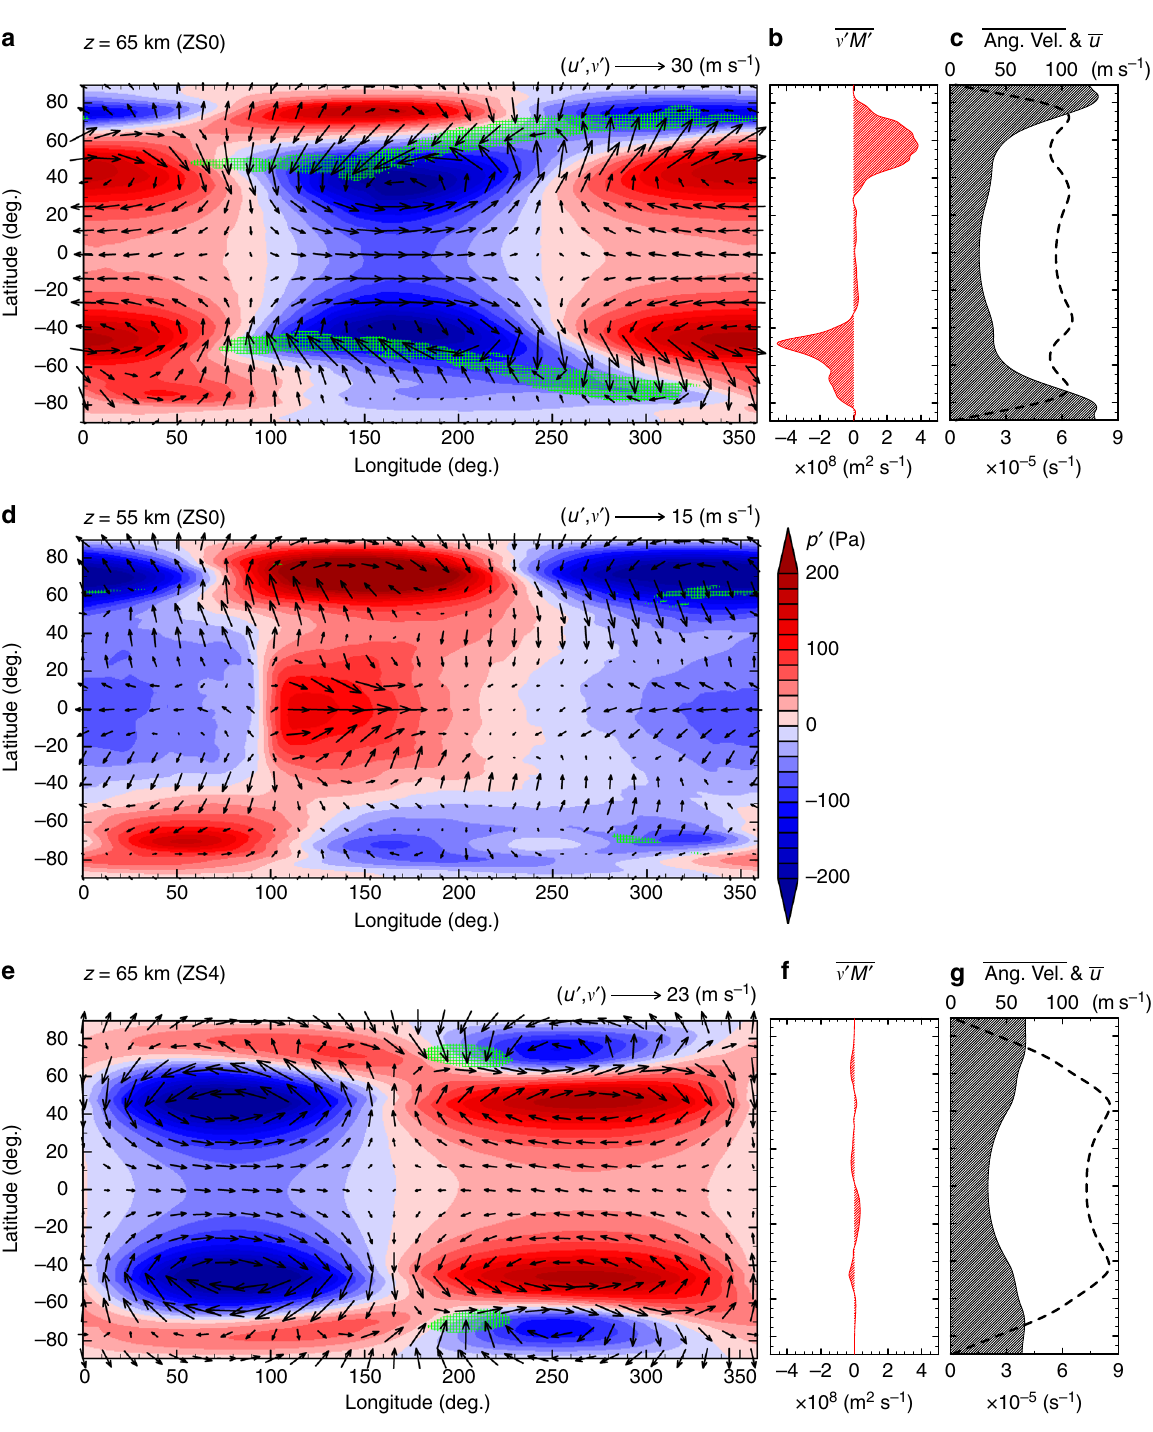
Fig. 7 Composite means of pressure anomaly p ′ (red-blue shading) superimposed by horizontal fl ow anomaly ( u ′ ; v ′ ). Panels a , d show the composite means on z = 65 km and 55 km, respectively, for ZS0; e shows that on z = 65 km for ZS4. Composite means are taken along the propagation speeds associated with the dominant Rossby-like waves at z = 65 km, the equatorial values of which are 75.6 m s − 1 for ZS0 and 96.0 m s − 1 for ZS4, respectively. Green hatching indicates strong downward fl ow ( w < − 0.03 m s − 1 ). b , f Temporal and zonal mean meridional transports of angular momentum by eddies at 65 km height for ZS0 and ZS4, respectively. The period of time-average is the same as that in Fig. 5. c , g Same as b and f but for angular velocity (shaded solid line, scales written in bottom axis) and zonal wind (thick dashed line, top